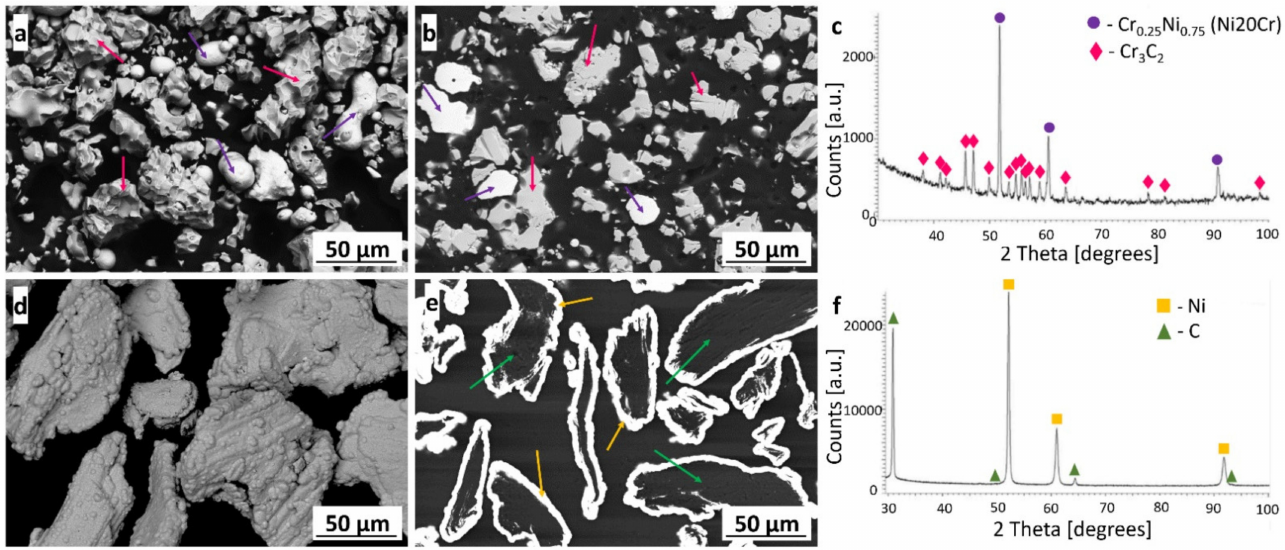
Figure 2. The morphology, cross-section, and XRD phase analysis of the Cr 3 C 2 -25(Ni20Cr) ( a – c ) and Ni25C ( d – f ) powders.